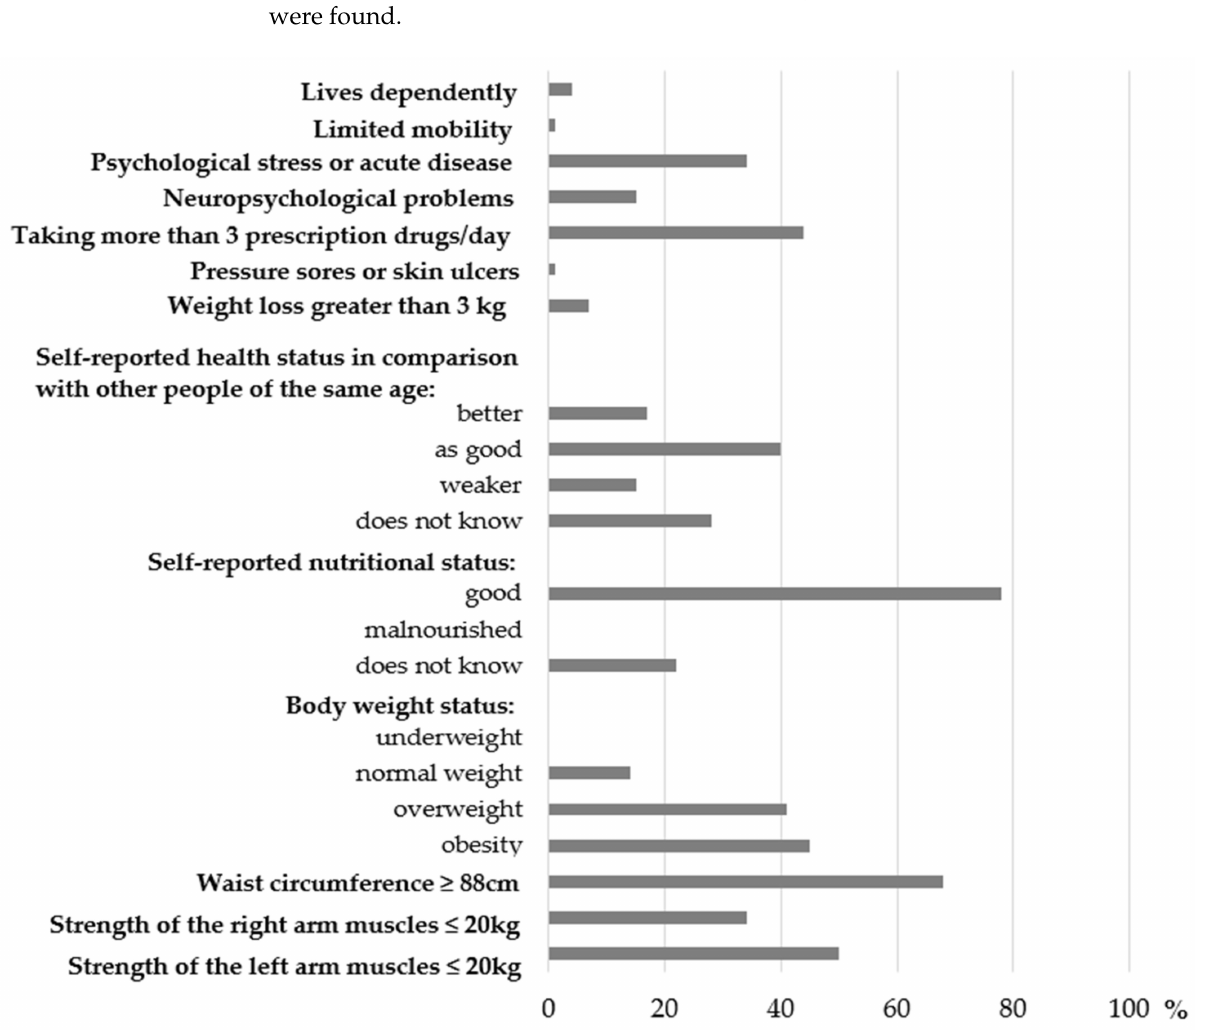
Figure 4. Distribution of the components of the Health-related Limitations Score (percentage of the total